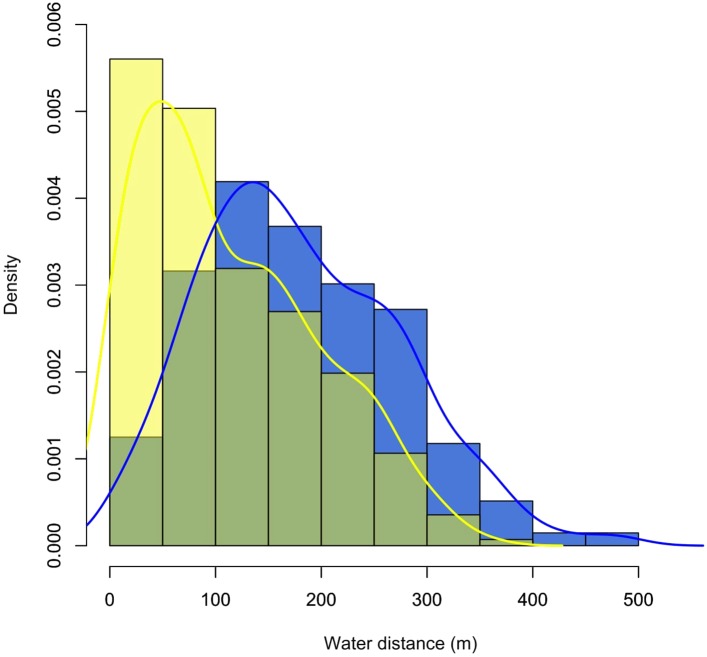
Density plot showing the distribution of records for the monitored individuals of C. globulosa in the Médio Juruá, Amazonas, Brazil, in relation to linear distances (m) to the nearest open waterbody.Yellow and blue bars and lines represent the dry and wet seasons, respectively.